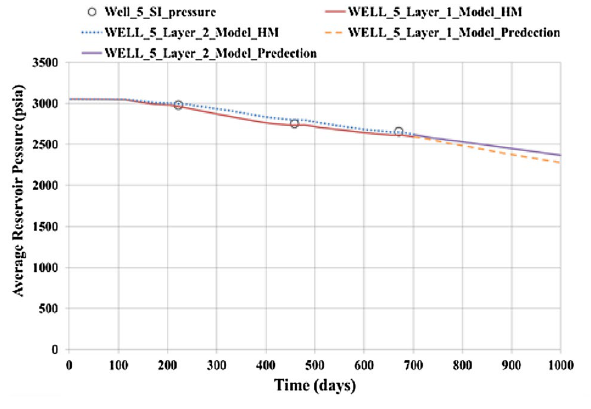
Fig. 10 Well 2 pressure history match and prediction (case 1)